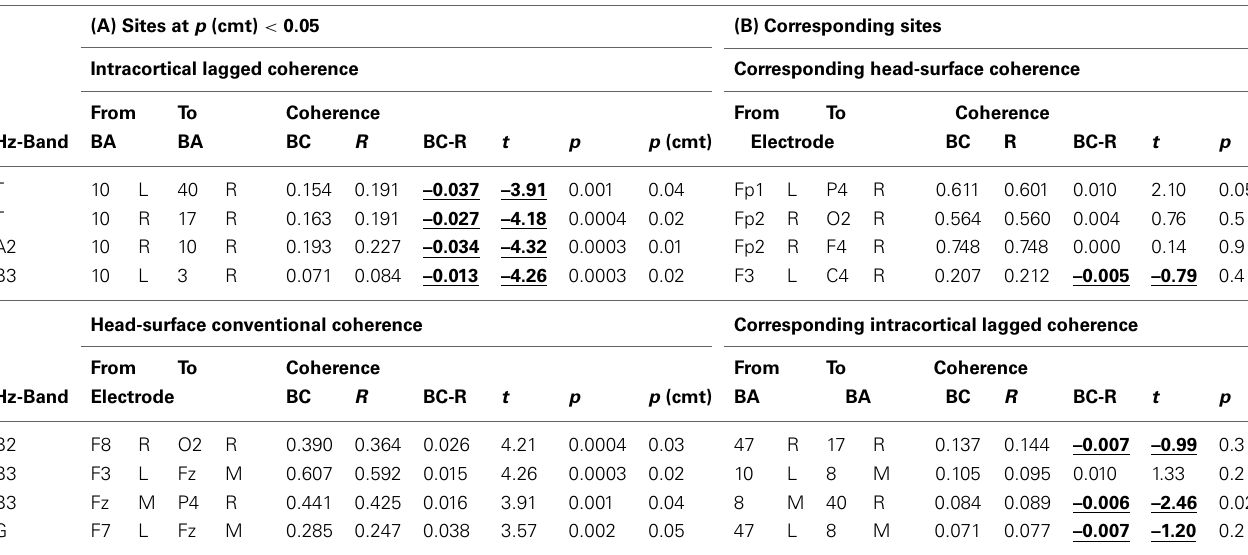
Table 2 | (A) Coherences that differed between breath counting (BC) and resting (R) at p (corrected) < 0.05. Intracortical lagged coherences (top), and head-surface conventional coherences (bottom). (B) Head surface coherences between electrode sites corresponding to the ROIs in a (top), and intracortical lagged coherences between ROIs corresponding to the electrode sites in a (bottom). (A) Sites at p (cmt) < 0.05 (B) Corresponding